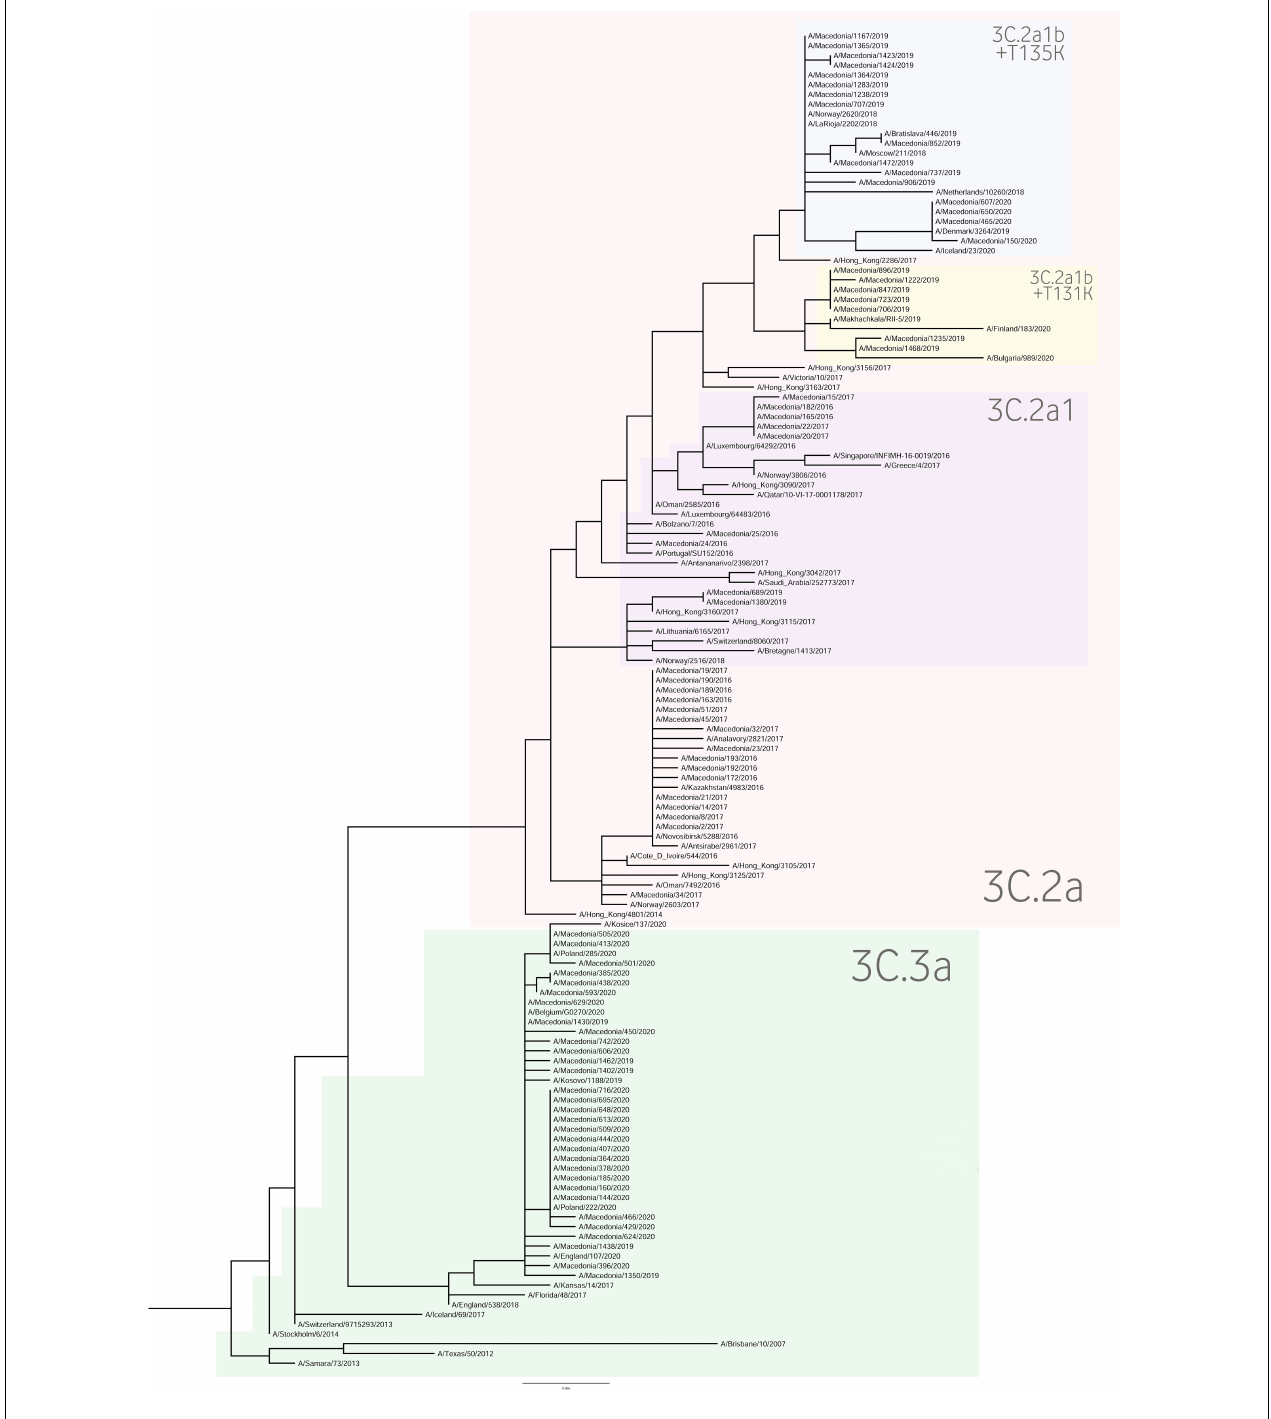
FIGURE 4 | A(H3N2) HA phylogenetic tree.